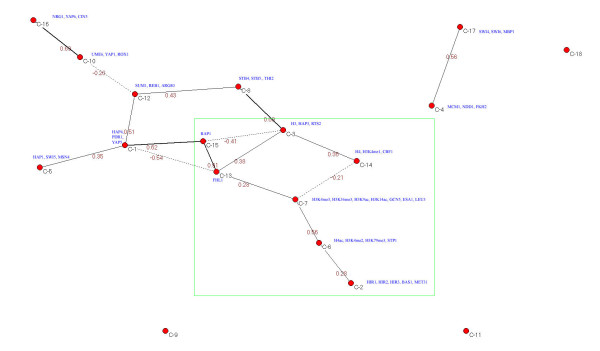
A protein-histone modification interaction network was predicted by applying Gaussian graphical models (significance level p < 0.003) on the centers of 18 protein clusters. Each cluster represents a group of proteins that share similar t-values (results of t-tests of functional binging sites versus the rest of binding sites in the genome, for binding of 203 yeast TFs in promoter and variation of 8 histone modifications in ORF - Pokholok et al.) across 32 yeast TFs: blue colored texts are representative proteins of each cluster, red colored number on each edge is partial correlation coefficient between two vertices.